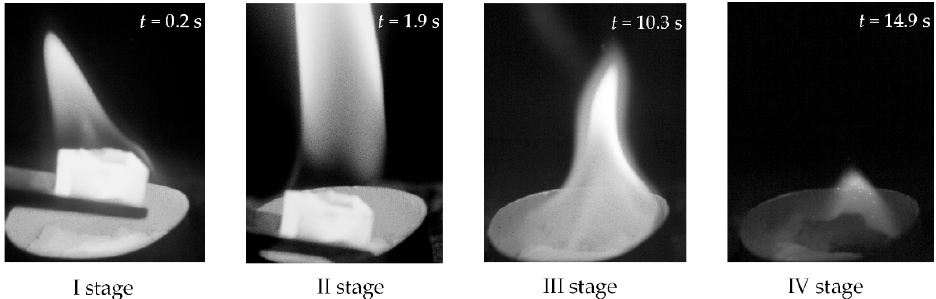
Figure 4. The main stages of gas hydrate combustion (local heating by a hot metal particle). The hydrate sphere diameter has a significant effect on the burning characteristic. As the sphere diameter increases, the flame goes up sharply, and the oscillation frequency decreases, whereas the maximum flame temperature remains constant. Flame param- eters such as oscillation characteristics, morphology, and temperature are traditionally considered important in the fundamental research into combustion [139]. The spectral measurements show [56] that the proportion of total flame brightness remains almost constant throughout combustion, i.e., the flame color does not change significantly over time. The overall intensity changes as the flame wavers around the hydrate source. The floating stream produced by the rising hot gases wavers too, which lends dynamic be- pale blue. In the case of spherical hydrate combustion [62], the flame fluctuation is